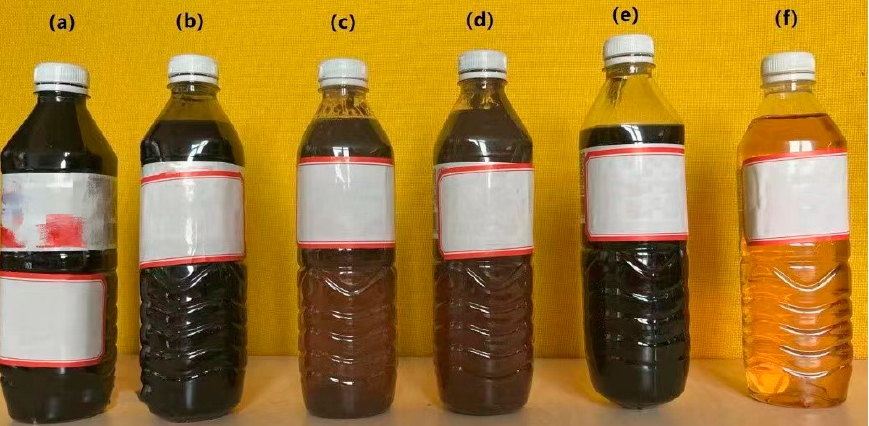
Figure 1. Leachate samples from six collections: ( a ) leachate raw water (LRW); ( b ) leachate effluent (LE); ( c ) internal circulation reactor effluent (ICRE); ( d ) aerobic effluent (AeroE); ( e ) anaerobic effluent (ANE); ( f ) MBR effluent (MBRE).